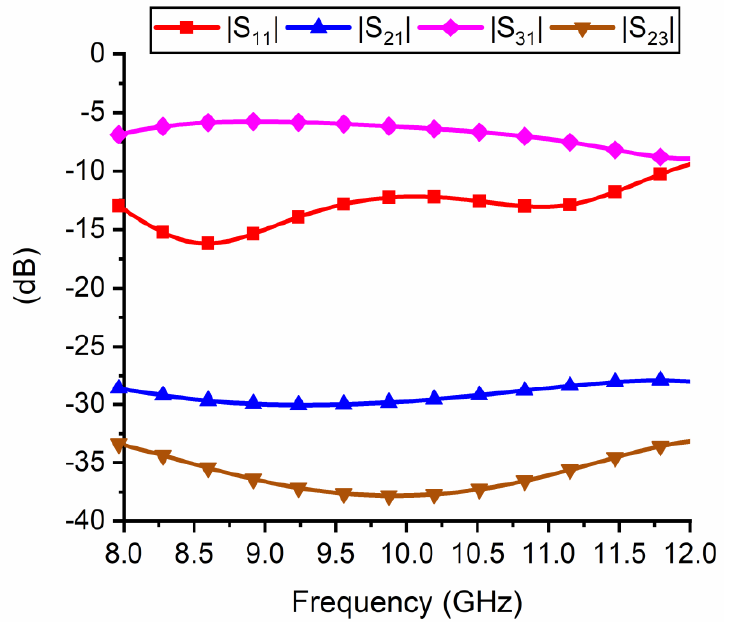
Figure 14. Scattering parameters of the T/R module in TX mode. The three ports have the following significance: port 1 is the “RF IN” port where the RF excitation signal is injected, port 2 is connected to the RX antenna (after the switch “off”), port 3 is connected to the TX antenna (after the switch “on”).